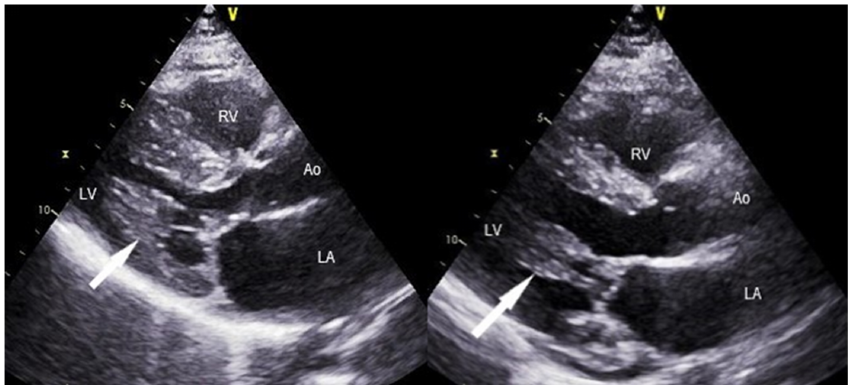
Figure 3. Preoperative ( left ) and postoperative ( right ) TTE showing the pathophysiological substrate for papillary muscle mobilization and secondary MV chordal cutting associated with septal myectomy in obstructive HCM. The arrow indicates a papillary muscle that has been freed surgically from its aberrant attachment to the LV free wall. In addition, a significant enlargement of the LVOT is noticed after surgery, along with posterior displacement of the mitral coaptation point.